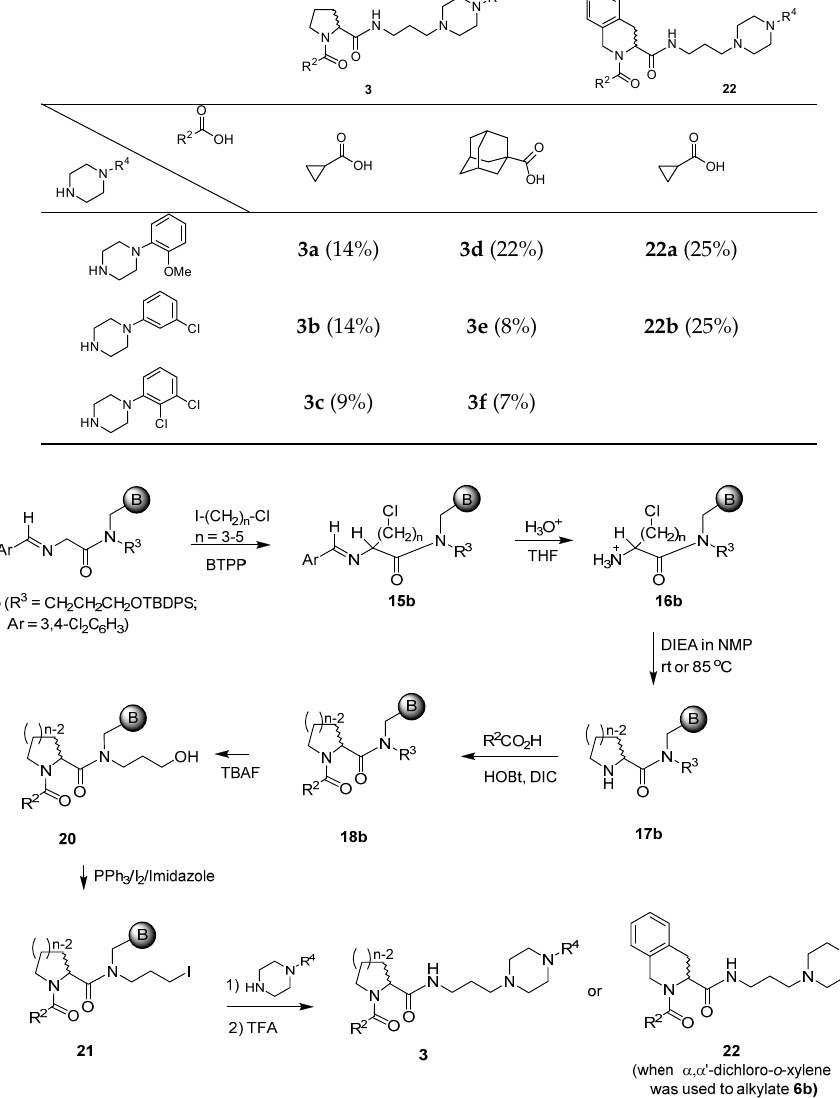
Scheme 4. Solid-phase synthetic route (using BAL-based aldimine resins) to proline and homologues substituted on both the amine and carbonyl residues.